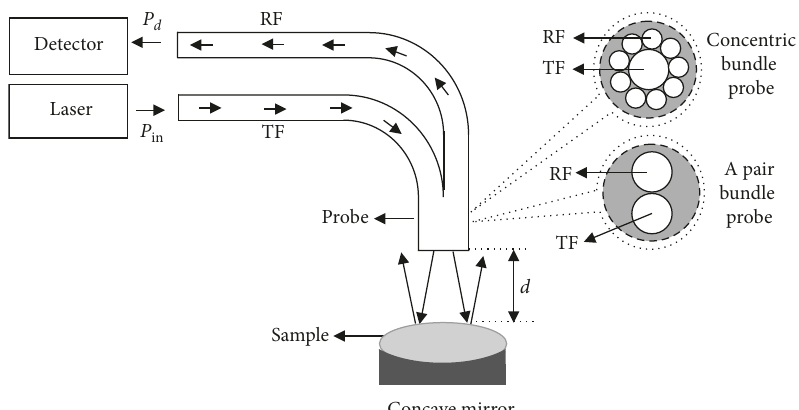
Figure 1: Sensor design of rhodamine B concentration in distilled water using fiber bundle and concave mirror as a reflector as well as a sample container.